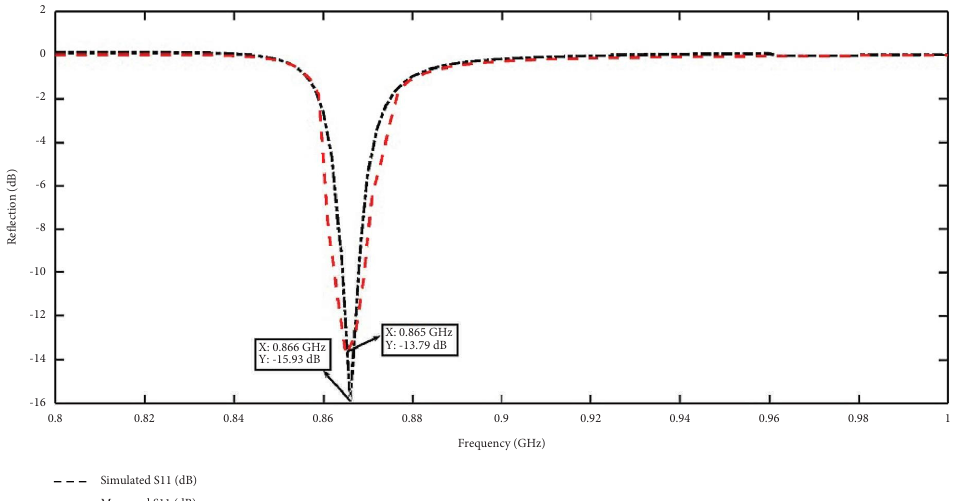
Figure 15: Simulated S 11 (dB) performance of the proposed tag.